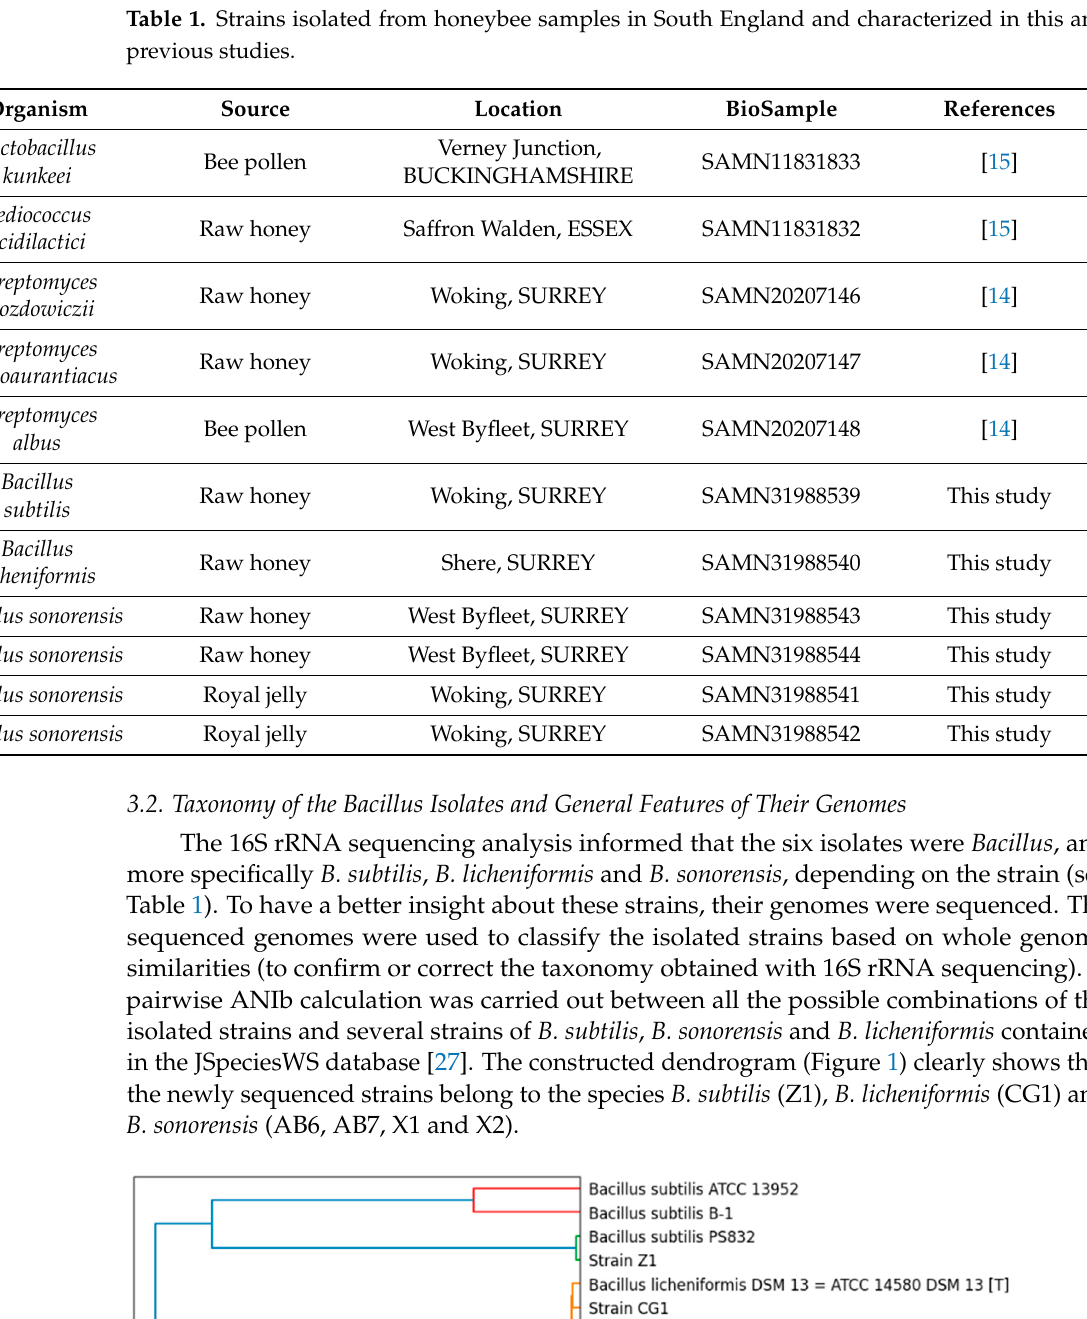
Table 2. Data obtained from the genomes of the six Bacillus strains isolated in this study. Strain Bases